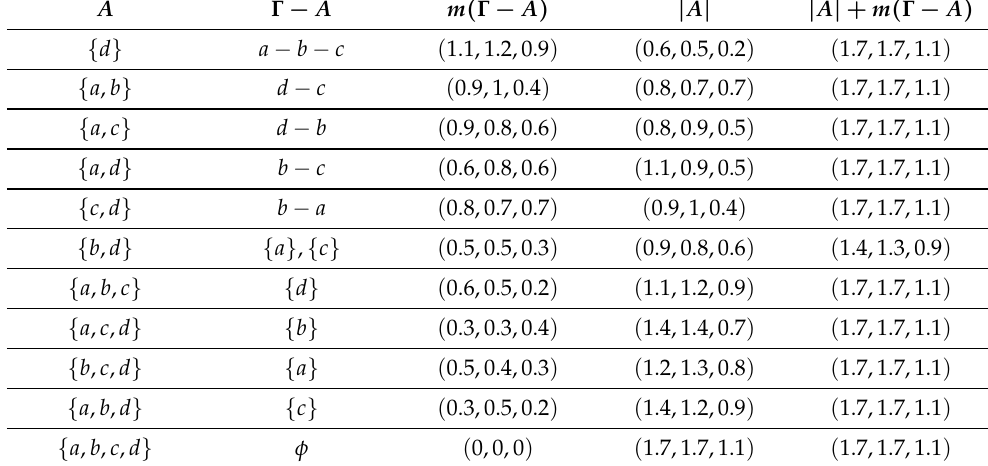
Figure 2. Domination integrity of 3PFG Γ . Table 1. Domination integrity of 3PFG Γ